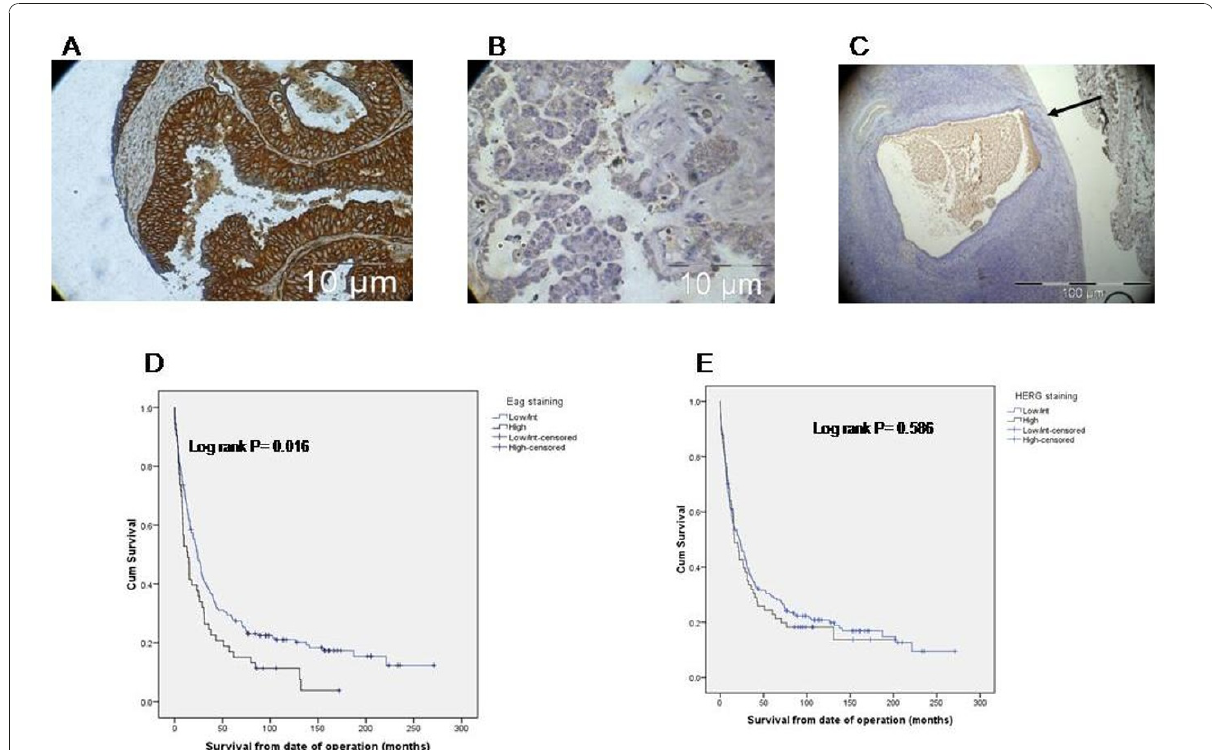
Figure 3 Immunohistochemical staining of ovarian cancer tissues and normal ovary and its correlation with survival. Representative section from a tissue microarray set showing (A) high and (B) low Eag immunohistochemical expression and low staining on the surface epithelium (arrow) of normal ovary (C). Similar results were obtained for HERG. (D) Kaplan-Meier survival curves from data represented on the above TMA show high Eag expression is associated with poor prognosis (P = 0.016), whereas increased HERG expression (E) is